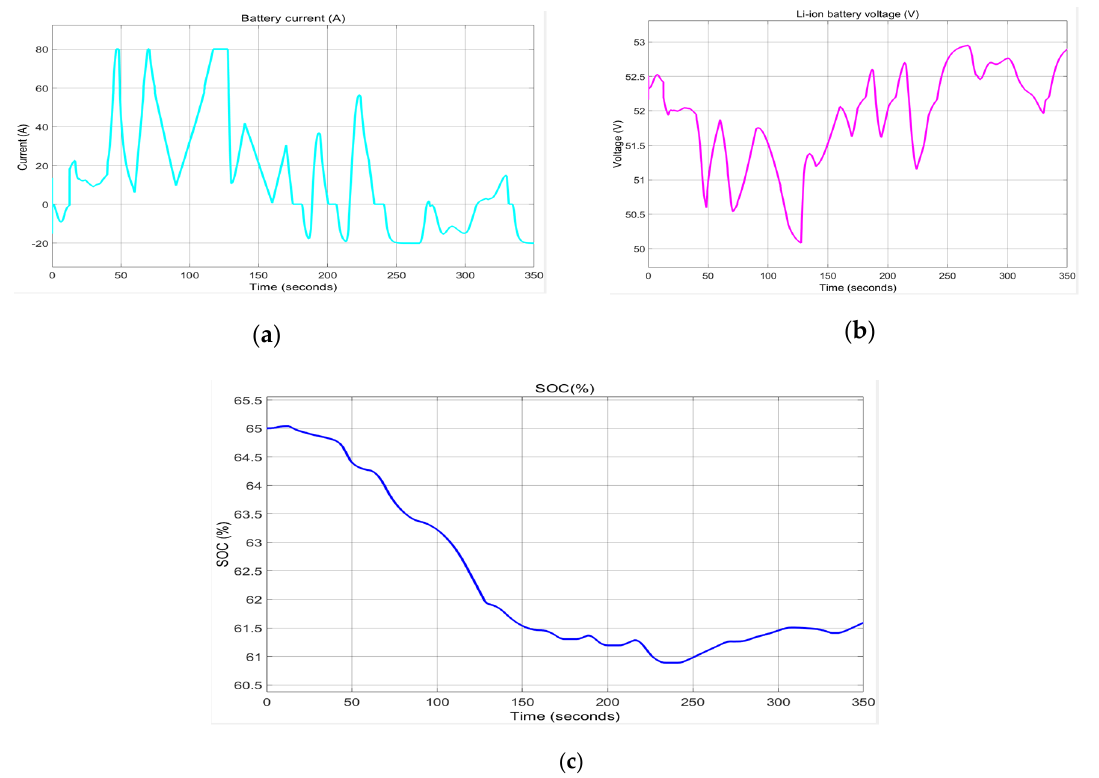
Figure 27. ( a ) Li-ion battery current; ( b ) battery terminal voltage; ( c ) battery